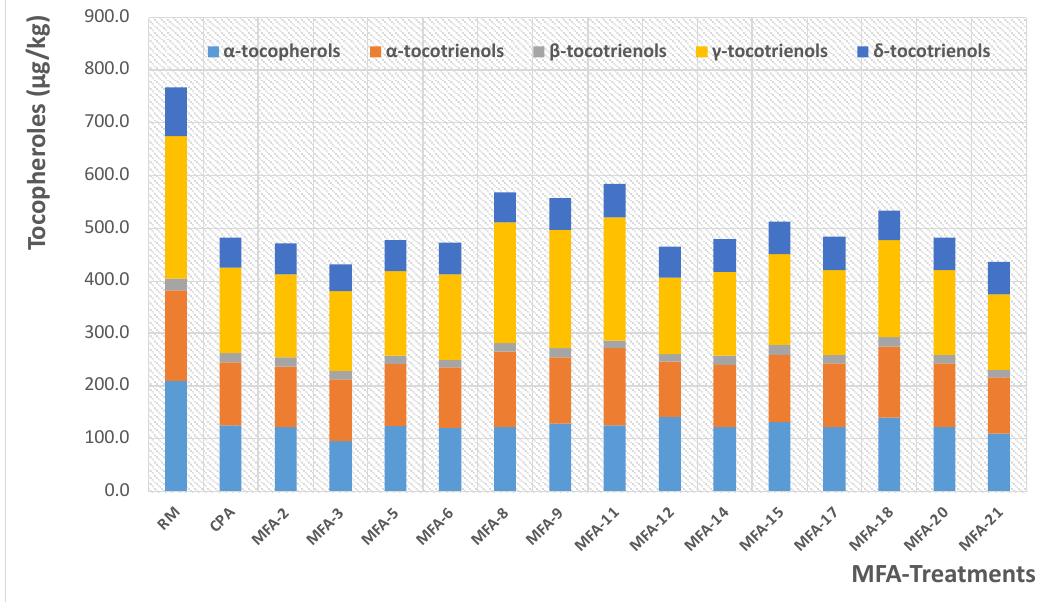
Figure 8. Variation of the antioxidant activity versus the MFA conditions.